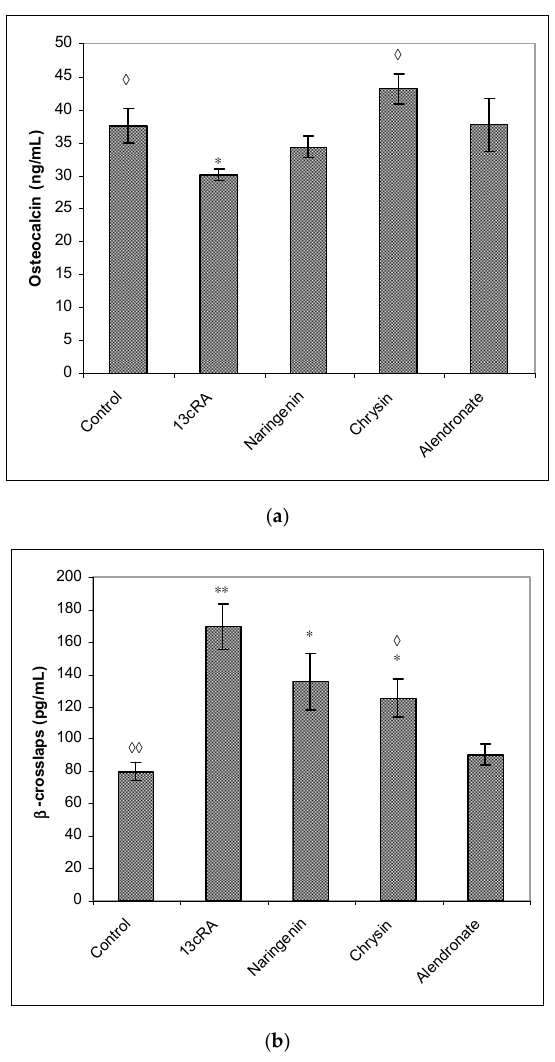
Figure 6. Effects of naringenin, chrysin, or alendronate on serum markers of bone turnover—osteocalcin ( a ) and β -crosslaps ( b ) in rats with retinoic-acid-induced osteoporosis. Rats were adminis- tered ig with retinoic acid suspension (80 mg/kg) once daily for 14 days. After inducing osteoporosis with 13cRA, rats were administered ig with naringenin (100 mg/kg), chrysin (100 mg/kg), or alen- dronate (40 mg/kg), once daily for the next 14 days. Results are expressed as means of seven samples per group ( n = 7) ± SEM. *—Statistically significant compared with control (* p < 0.05; ** p < 0.01); ◊ — Statistically significant compared with 13cRA ( ◊ p < 0.05; ◊◊ p < 0.01). 2.7. Changes in Biochemical and Haematological Parameters and Pro-inflammatory Cytokines Treatment with 13cRA increased ALP and LDH levels ( p < 0.05; p < 0.05) (Table 2). Naringenin significantly reduced ALP, AST, and LDH values ( p < 0.05; p < 0.05; p < 0.001)